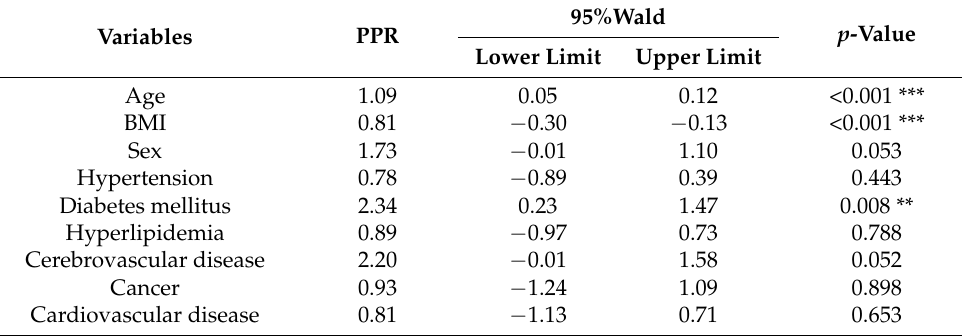
Table 3. Relationship between sarcopenia and age, BMI, sex, and medical